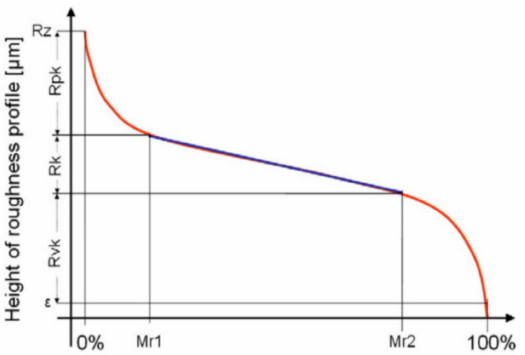
Figure 3. Bearing area ratio—ISO